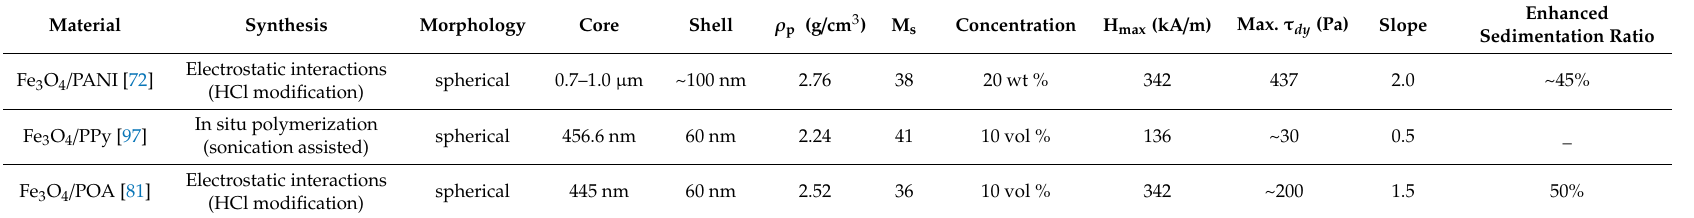
Table 3. Parameters of conducting polymer-coated nanoparticles applied to MR